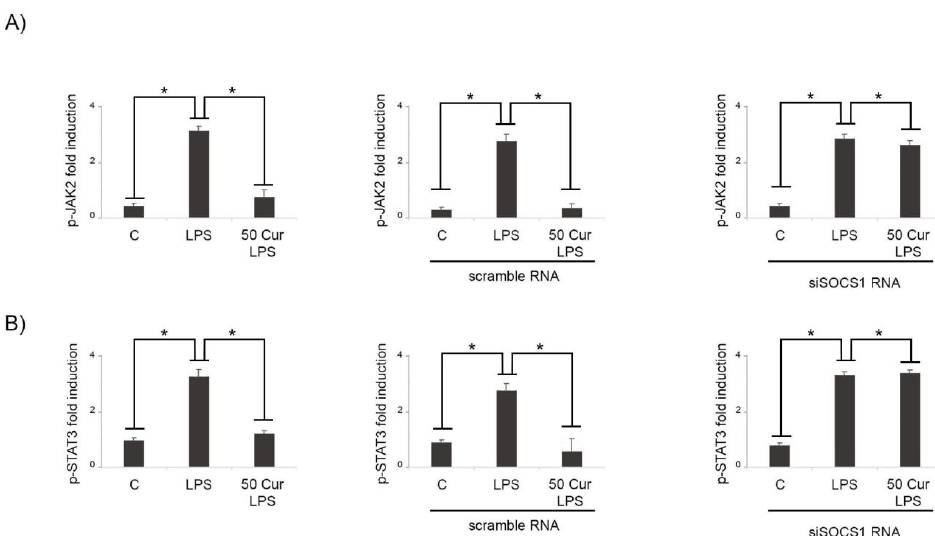
Figure 3. E ff ects of SOCS-1 silencing on JAK2 / STAT3 activation in BV-2 cells. Microglial cells were transfected with either control siRNA (scramble RNA) or SOCS-1 specific siRNA (siSOCS1 RNA). Untransfected cells were used as control (left A and B). ( A ) RT-PCR analysis of p-JAK2 expression in LPS-activated cells (LPS) in absence or in presence of 50 µ M curcumin (50 Cur + LPS). ( B ) RT-PCR analysis of p-STAT3 expression in LPS-activated cells (LPS) in absence or in presence of 50 µ M curcumin (50 Cur + LPS). Results are expressed as means ± SD of five independent experiments. * p < 0.05.